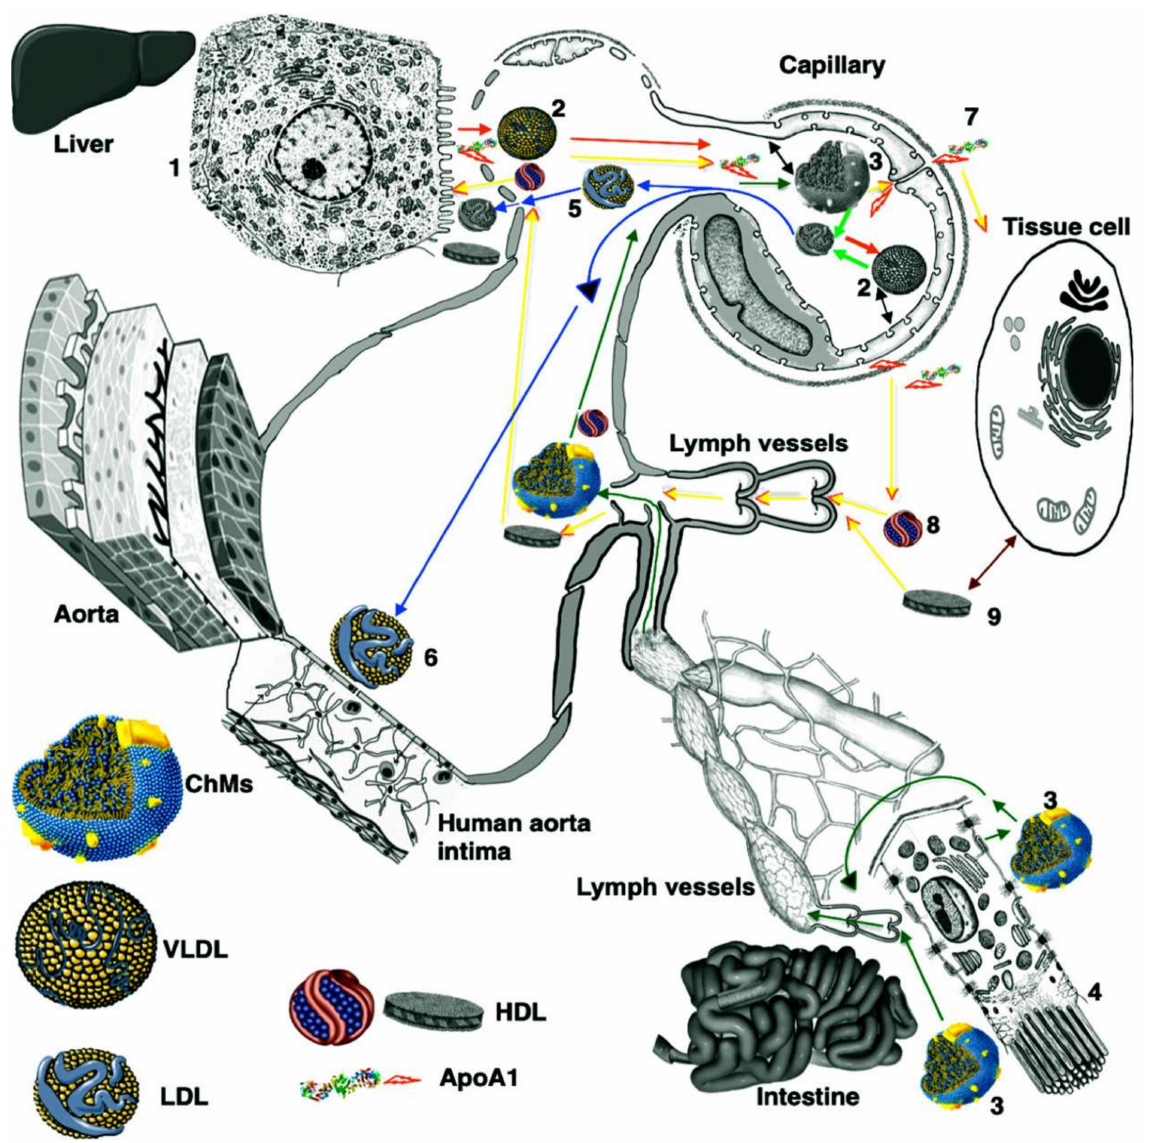
Figure 3. Scheme of LDL and chylomicron circulation and role of enterocytes according to Miron- ov et al.